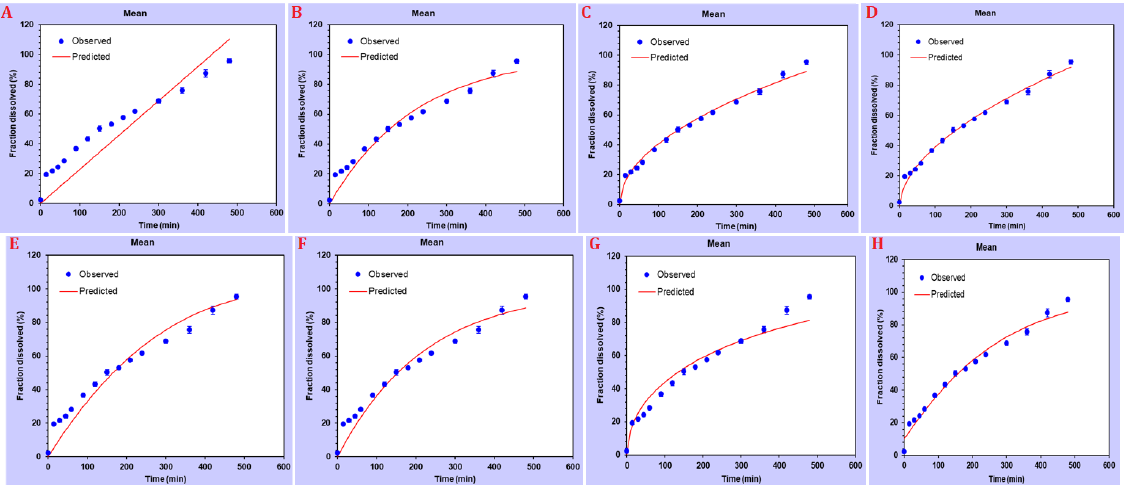
Figure 5: Diltiazem HCl profile of predictive dissolution (Qp) and experimental results (Qo) versus time (n = 6). A Zero order; B First order; C Higuchi; D Korsmeyer Peppas; E Hixson Crowell; F Hopfenberg; G Baker-lonsdale; H Weibull